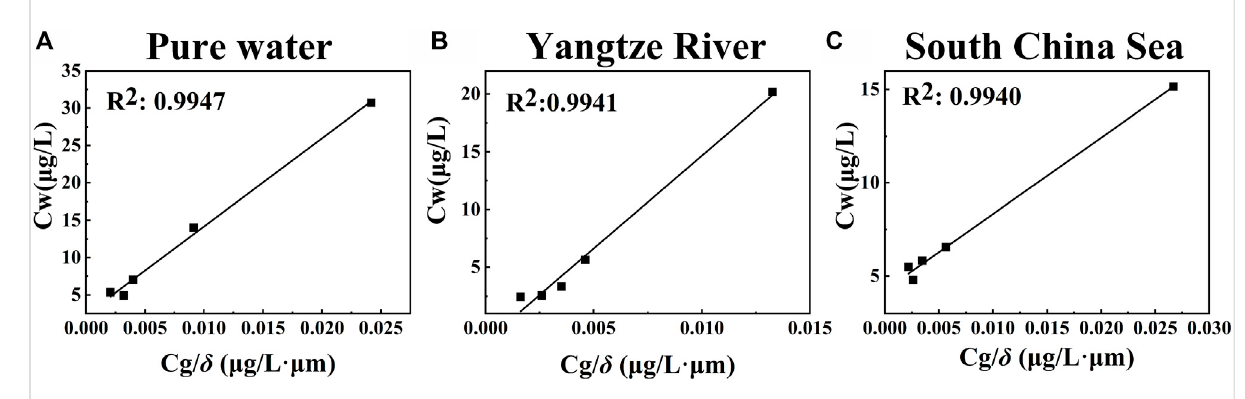
Uptake of CN from the gas-phase on water fi lms with varying thicknesses and different